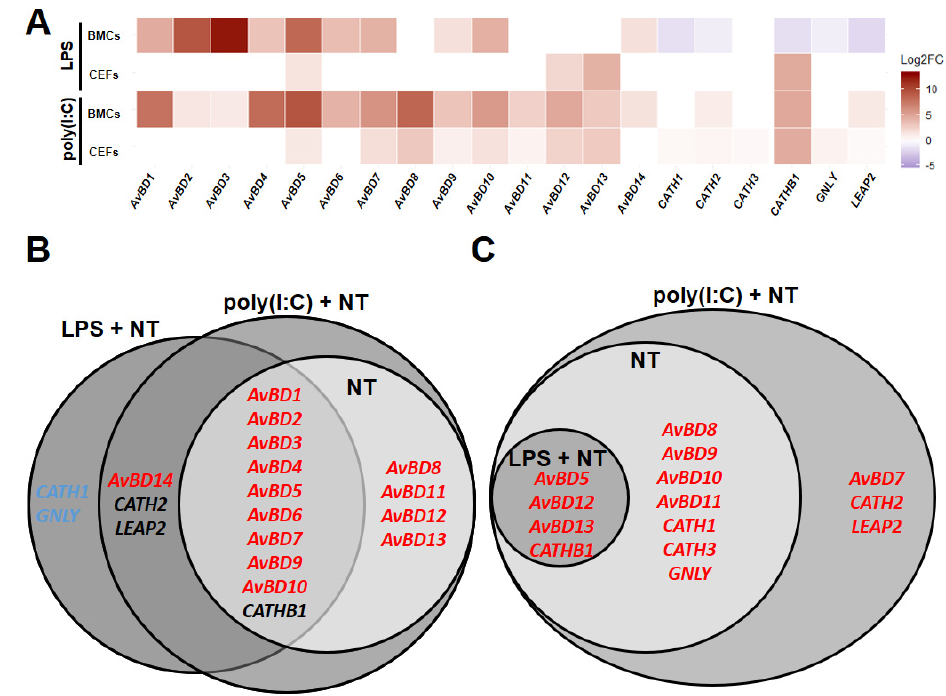
Figure 4. Line-dependent expression of host defense peptides (HDPs) with LPS or poly(I:C) treatment. Relative expression (Log 2 fold change (Log2FC)) of HDPs comparing Fayoumi to Leghorn in LPS- + non-treated (LPS + NT) or poly(I:C)- + non-poly(I:C)-treated (poly(I:C) + NT) BMCs or CEFs ( A ), Venn diagram for significantly di ff erentially expressed ( p < 0.05) HDP in BMCs comparing Fayoumi to Leghorn in non-treated (NT), LPS + NT or poly(I:C) + NT. ( B ) Venn diagram for significantly di ff erentially expressed ( p < 0.05) HDP in CEFs comparing Fayoumi to Leghorn in NT, LPS + NT or poly(I:C) + NT. ( C ) Red font color indicates significantly higher expression in Fayoumi compared to Leghorn. Blue font color indicates significantly higher expression in Leghorn compared to Fayoumi. Black font color indicates higher expression in Fayoumi with poly(I:C) and in Leghorn with LPS. BMCs, bone marrow-derived cells; CEFs, chicken embryonic